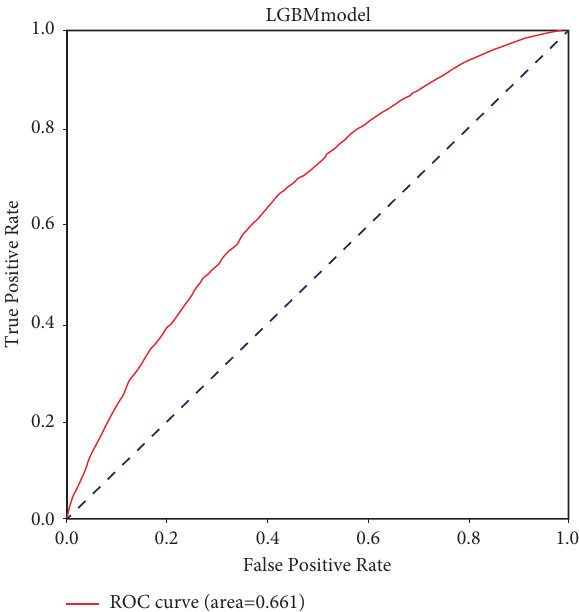
Figure 5: ROC curve of the automatic feature group A.